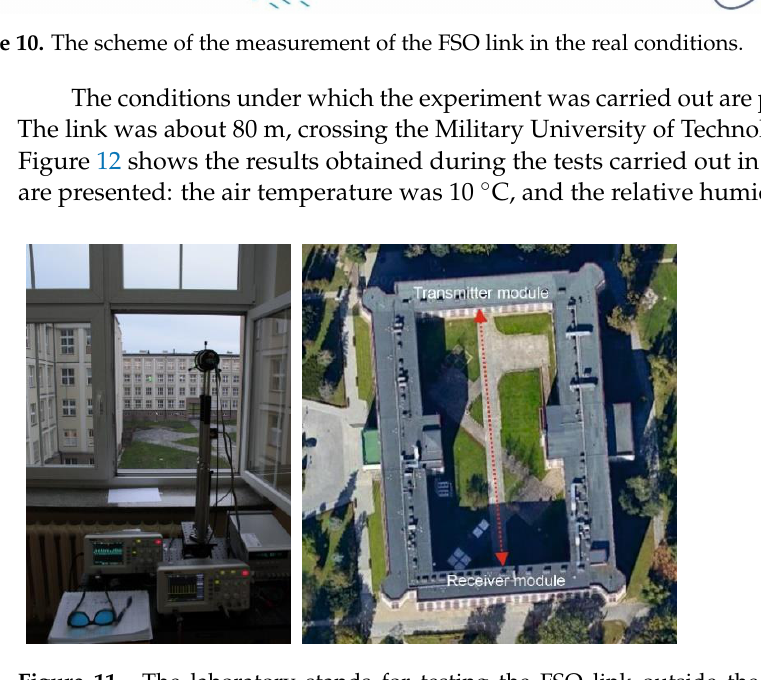
Figure 11. The laboratory stands for testing the FSO link outside the Military University of Technology building.